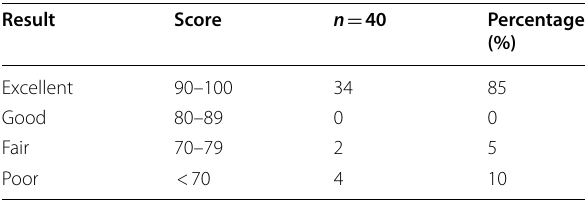
Table 2 Grading of functional results based on the follow‑up